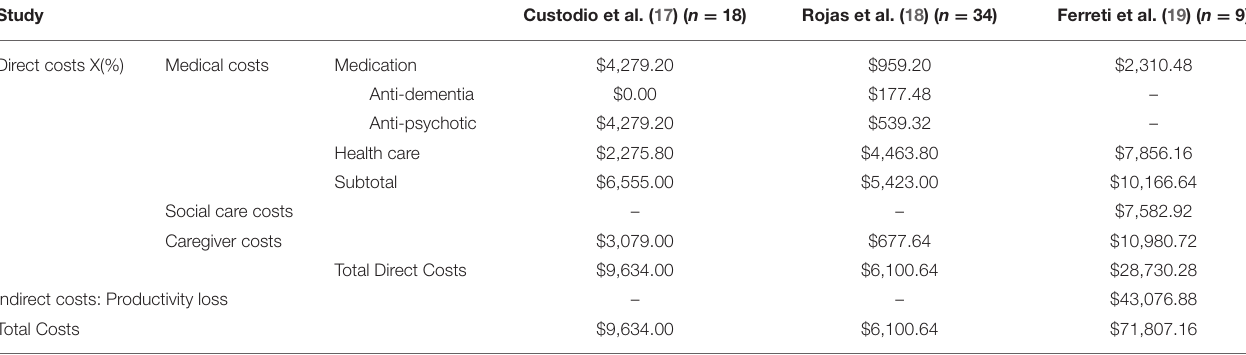
TABLE 2 | Annual cost-of-illness based on studies on frontotemporal dementia in Latin America.